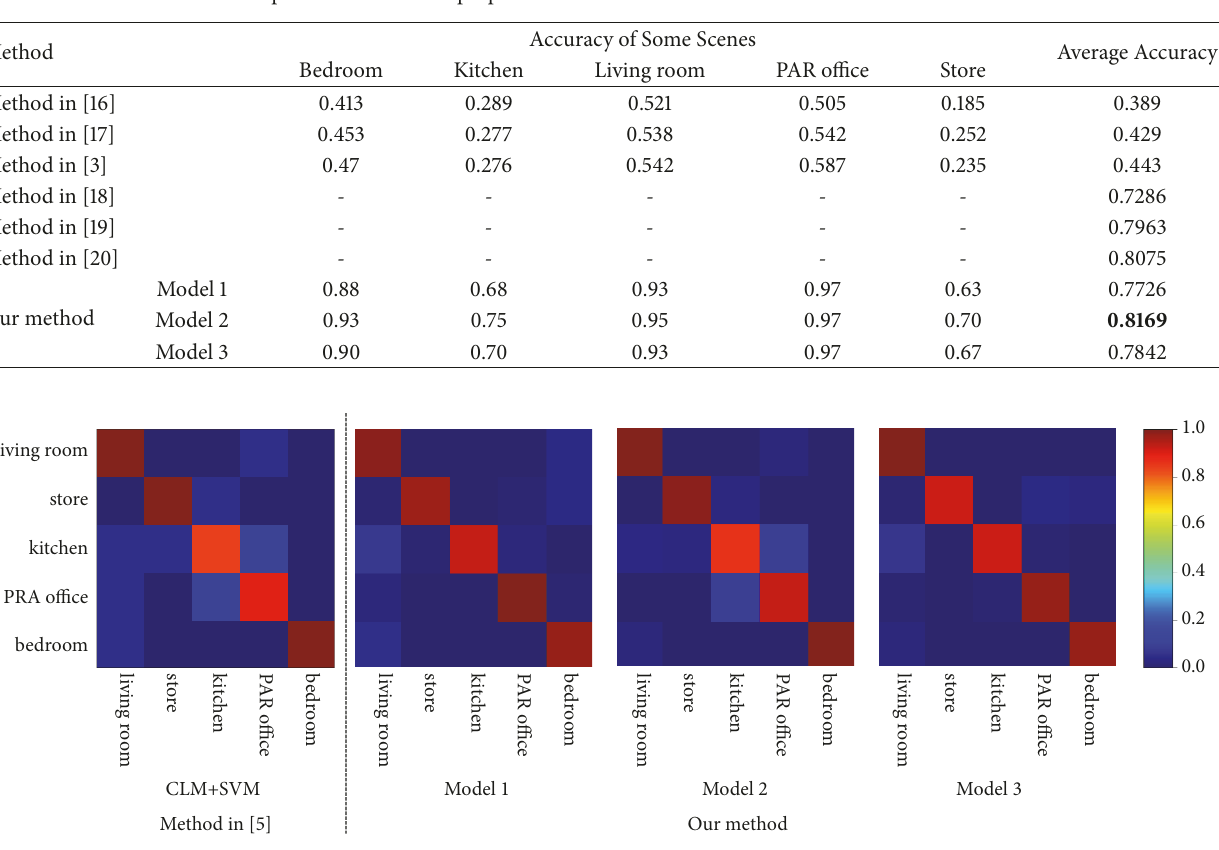
Figure 7: Comparison of scene classification confusion matrixes between the method in [5] and our